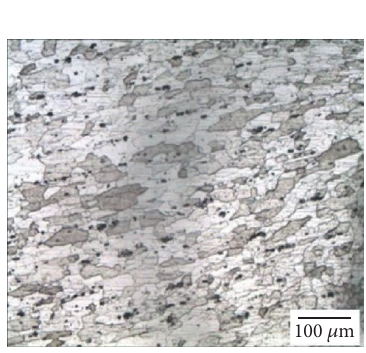
Figure 6: Optical micrograph of the as-received AA2014-T6 alloy.